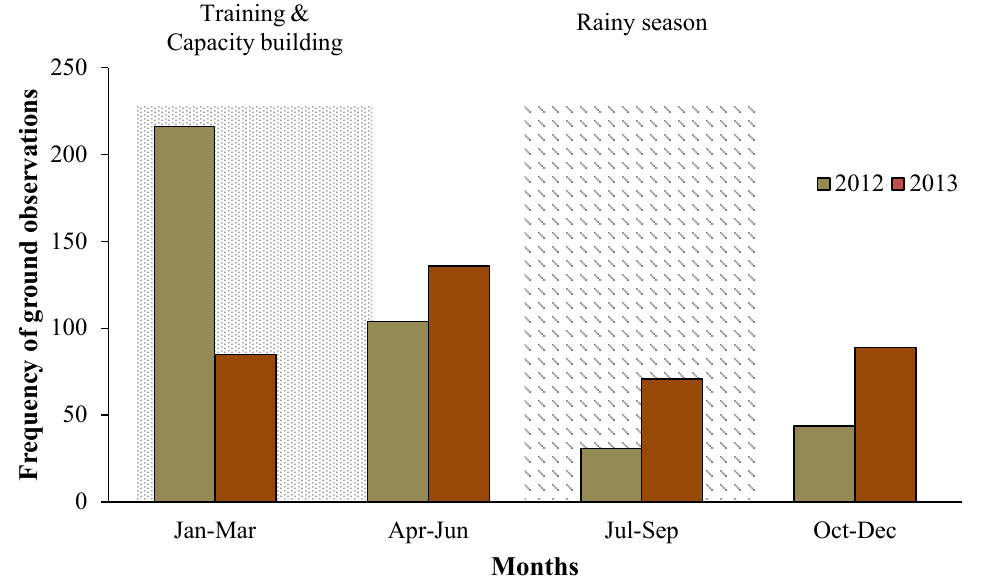
Figure 4. Number of observations collected by local experts in 2012 and 2013; all observations in 2012 were acquired using an analogue (paper-based) system, whereas observations acquired in 2013 were collected using either analogue or digital (smart phone-based) methods.